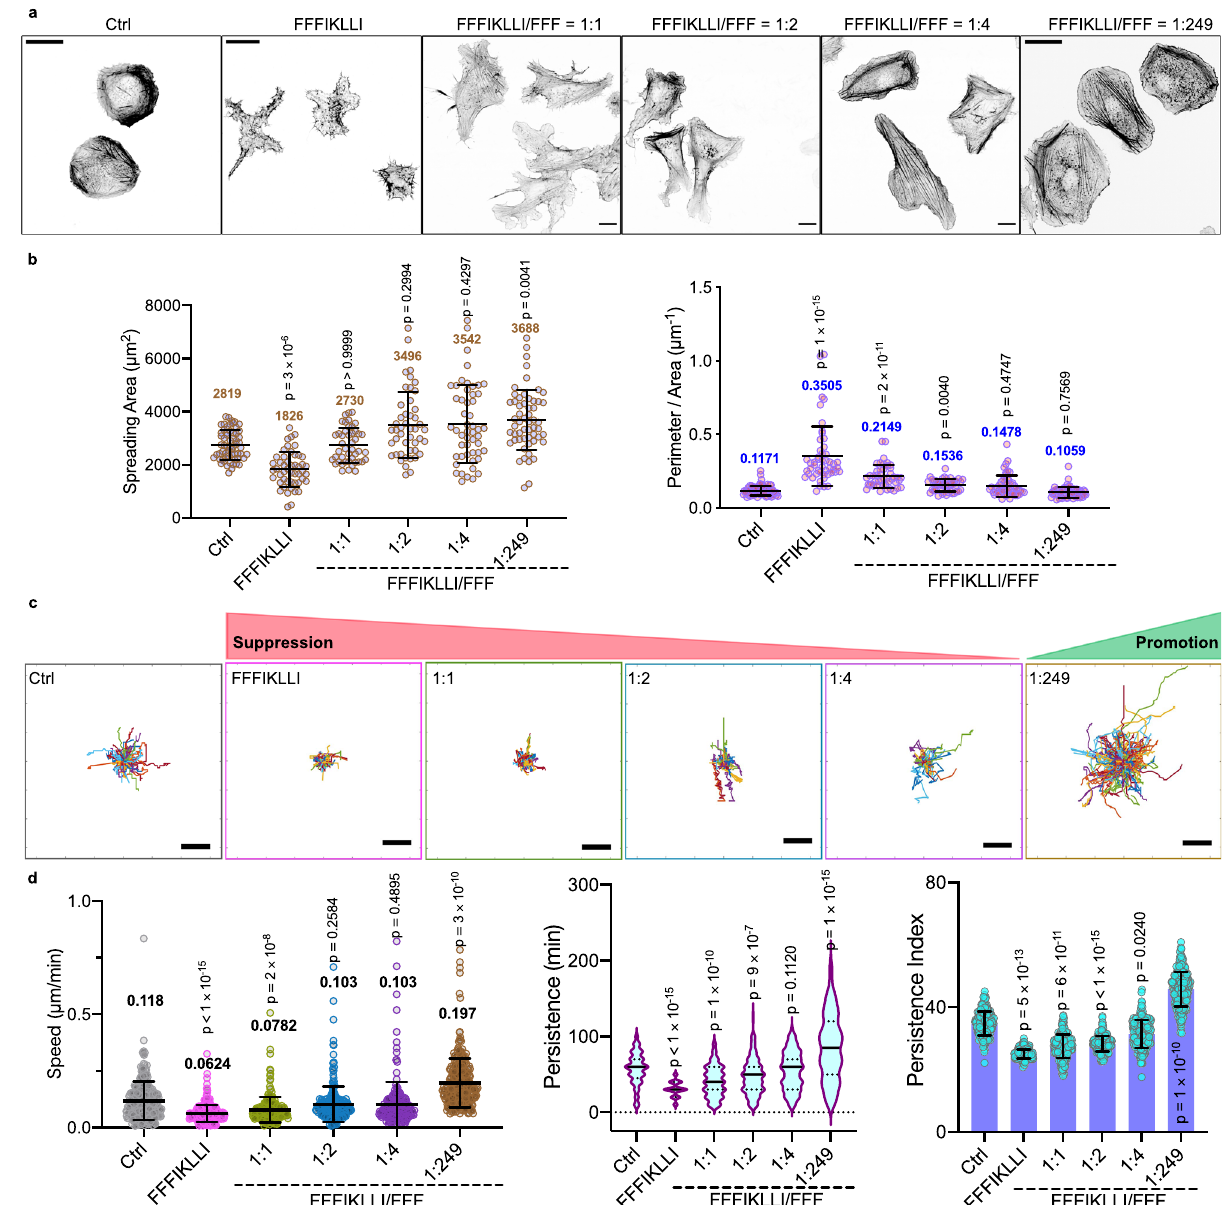
Fig. 2 | Nano fi laments with various ligand presentations regulate both cell shapeandcellmigration.a ThephalloidinstainingofHuh-7cellswithandwithout the treatment of various nano fi laments. Scale bars represent 20 μ m. b The spreading area and the perimeter area ratio of HuH-7 cells under various condi- tions.Kruskal-WalliswithDunn ’ smultiplecomparisonstestwasusedforanalysisof the data. Data are presented as mean±s.d. From left to right, n =61, 49, 45, 46, 51, 56cells,respectively.Thetrajectoryplots c ,andthecorrelatedquantitativeanalysis